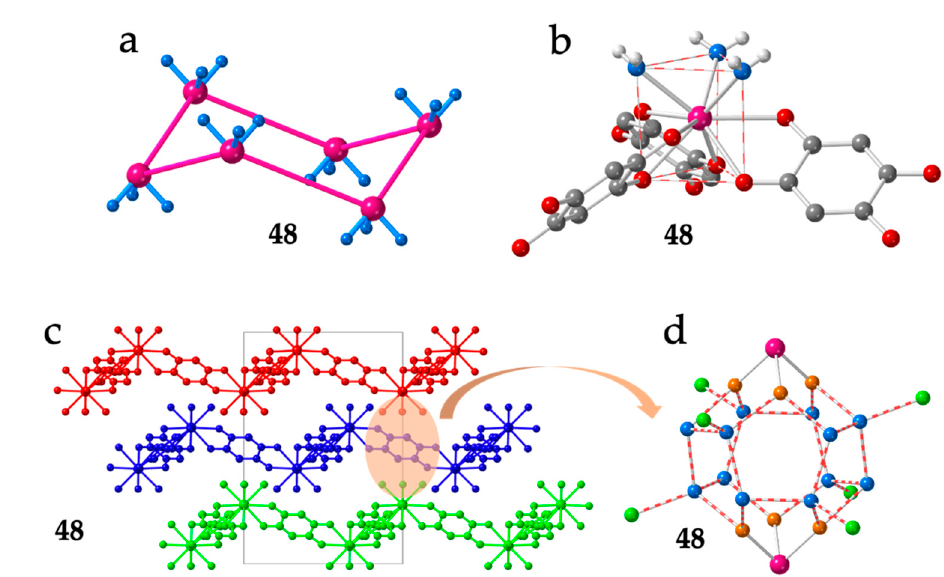
Figure 6. Structure of compound 48 . ( a ) Side view of one hexagonal ring. ( b ) View of the coordination environment of the Dy(III) ions. ( c ) View of three consecutive layers. ( d ) View of the Dy 2 (H 2 O) 18 cluster connecting two nonconsecutive layers. Orange atoms are the coordinated water molecules. Blue (and green) atoms are the crystallization water molecules belonging (or not) to the cluster. Colour code: Ln = pink, C = grey, O anilato = red and O water = blue/green/orange.